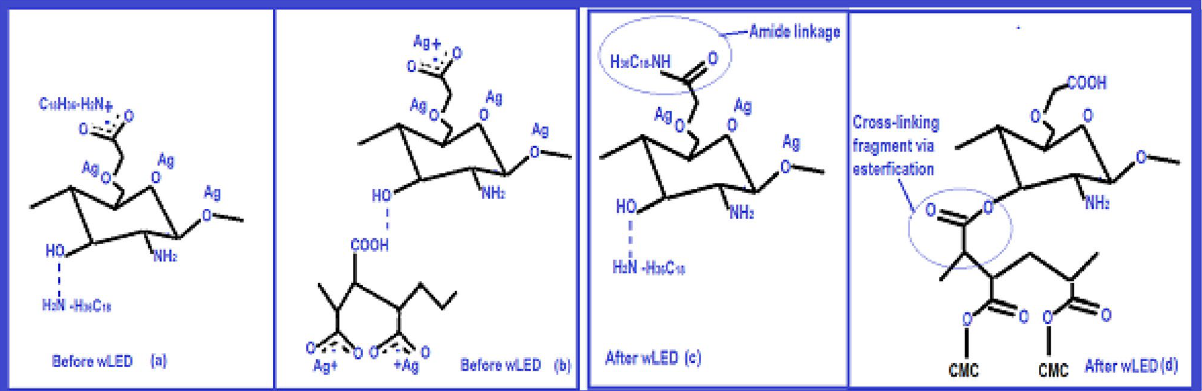
Figure 1. Schematic illustration of syntheses process: (a) interaction CMC functional groups with amine groups of ODA via alkyl-NH2 carboxylates complexes and CMC-O- (ether)… +Ag before wLED exposure; (b) CMC-OH…HOOC-MA (hydrogen bonding), CMC-COO-… +Ag ions; and MA-COO-… +Ag ions fragments before wLED exposure; (c) grafting (amidization) fragment of ODA with CMC carboxyl groups after wLED exposure; (d) the esterification or cross-link bonding fragment between CMC and MA macromolecules after